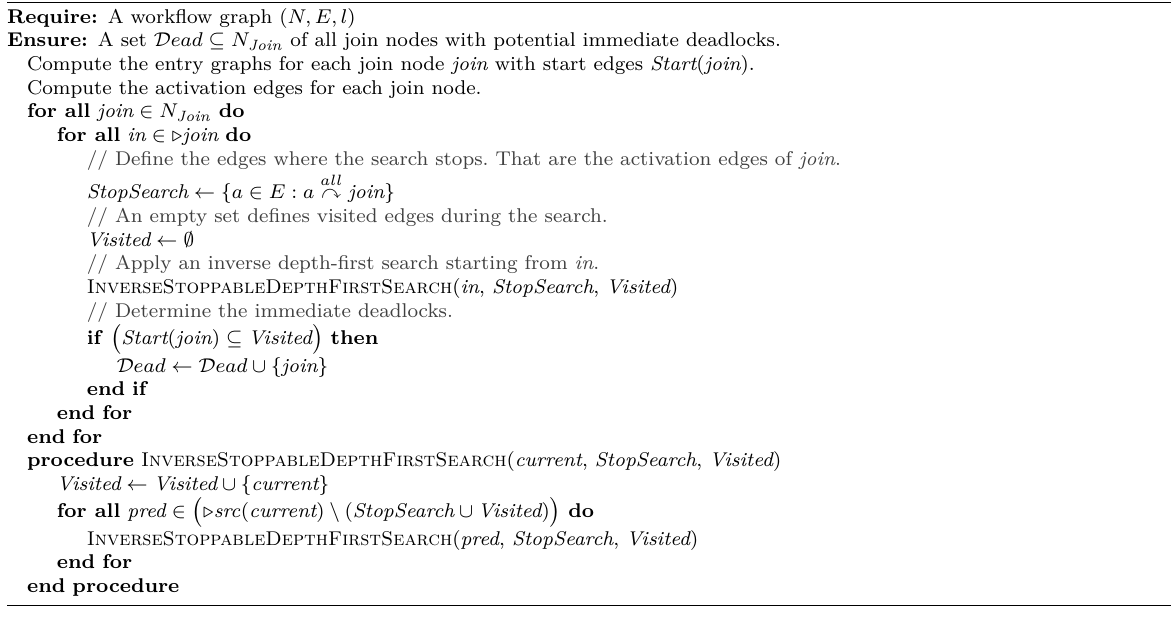
Algorithm 2 Determination of immediate